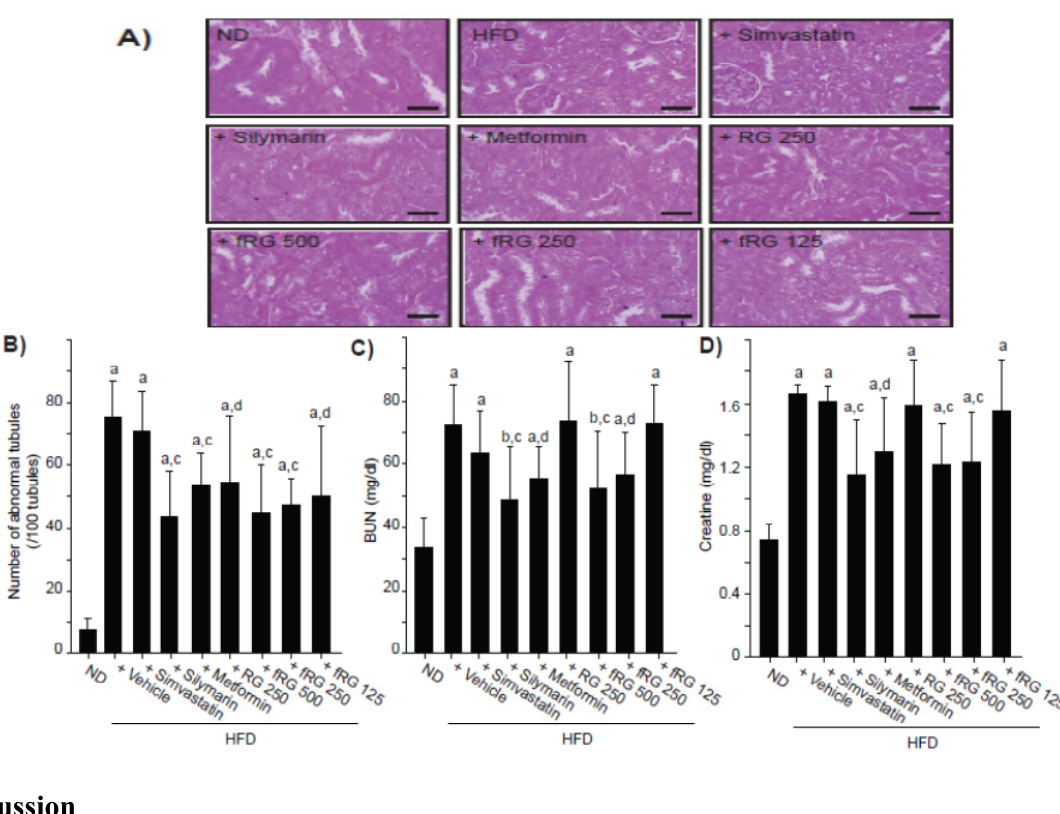
Figure 5. Effect of fRG on HFD-induced kidney damages. The representative histological images of kidney ( A ) were stained with H & E (Scale bars = 80 μ m). The number of vacuolated tubules among 100 tubules ( B ), BUN ( C ), and creatinine ( D ) in blood were measured in ND-, HFD-, HFD + simvastatin-, HFD + silymarin-, HFD + metformin-, HFD + RG- and HFD + fRG-fed mice. All values were expressed mean ± S.D. of eight mice (Significant as compared with ND-fed mice, a p < 0.01; b p < 0.05; significant as compared with HFD-fed mice; c p < 0.01; d p <